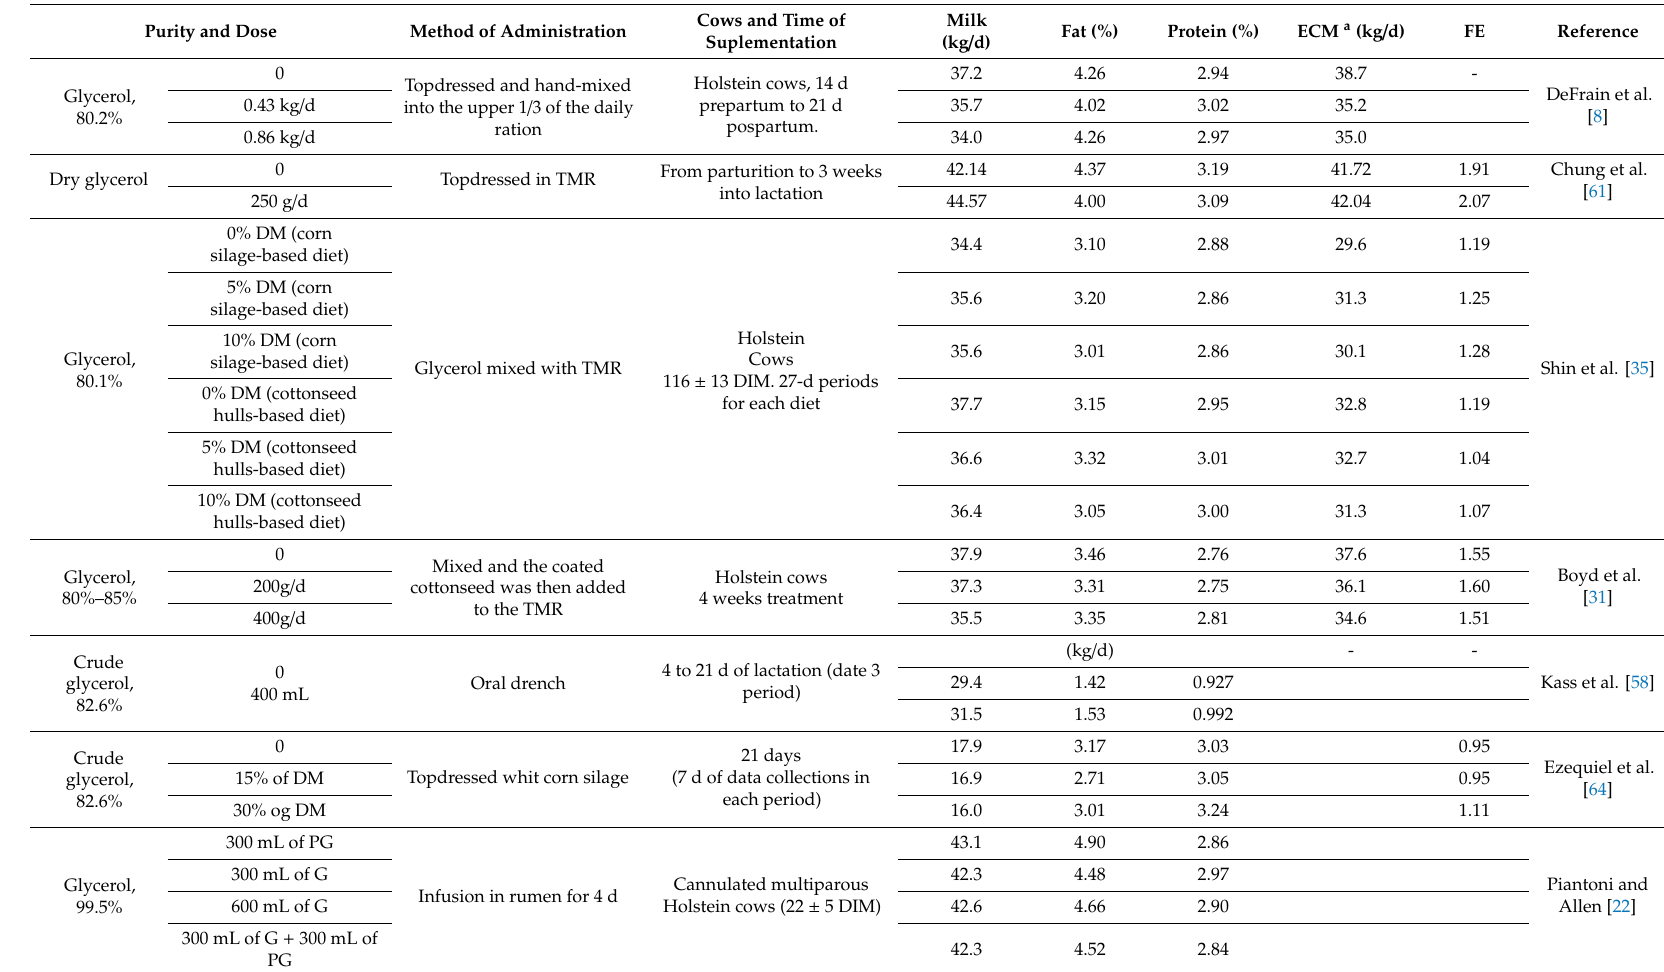
Table 3. The e ff ect of glycerol on milk yield and milk composition in dairy